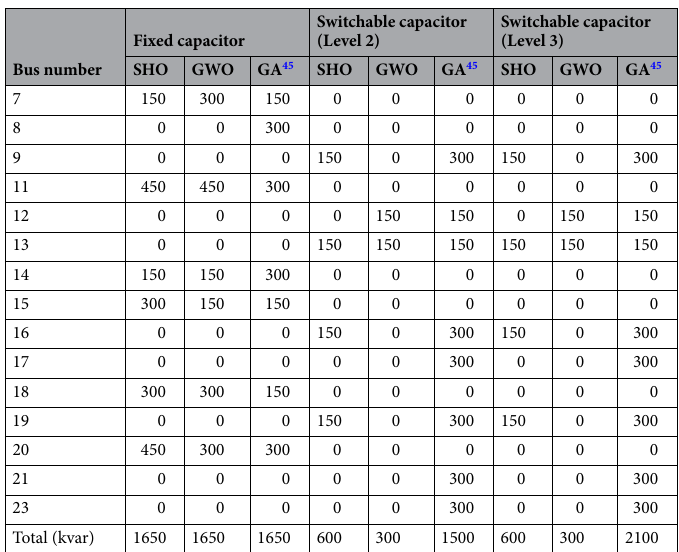
Table 10. Optimal capacitor placement at 24-bus network in the mode of cosφ#1.